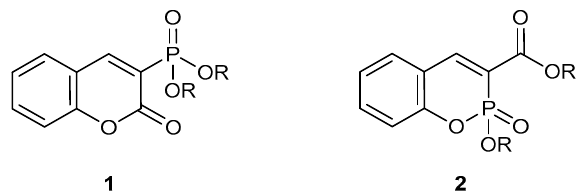
Figure 1. Phosphorus-containing structures 1 and its phosphoroheterocyclic analogue 2 .